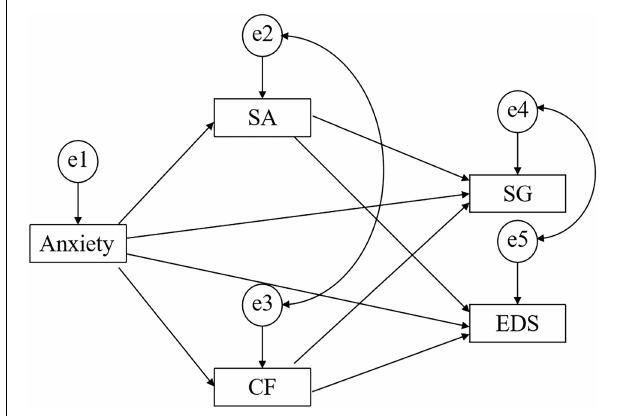
FIGURE 1 | A theoretical model relating state anxiety (Anxiety) to social gain (SG) and eating disorder symptoms (EDS). CF, Cognitive Flexibility; SA, Sustained